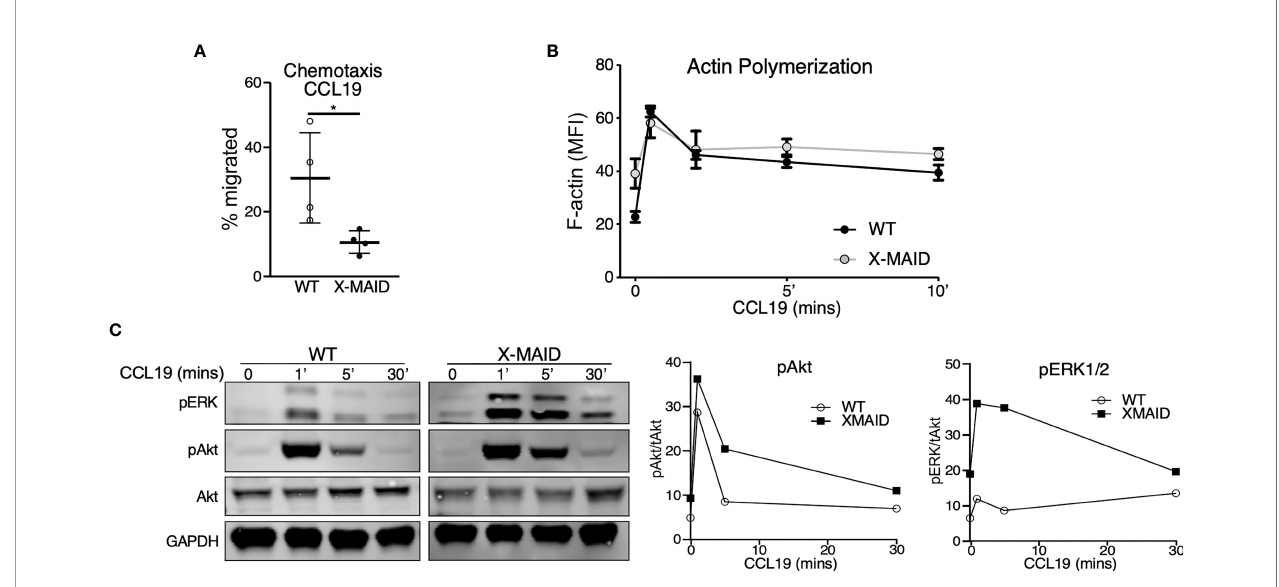
FIGURE 6 | X-MAID thymocytes are unable to properly chemotax despite intact signaling. WT or X-MAID CD4 SP thymocytes were (A) placed in the upper chamber of a 5 m m pore transwell with 100ng/ml CCL19 in the media of the bottom chamber and incubated at 37 degrees for 2 hours. Cells in the bottom chamber were counted and percent migrated calculated. Graph shows results from 4 independent experiments, with each data point representing an average of three technical replicates from one experiment. Each experiment used pooled cells from 3-5 X-MAID mice, and cells from one matched WT littermate control. Data represent means ± StDev. Statistics were calculated using a Student ’ s t test, *p < 0.05. (B) WT or X-MAID CD4 SP thymocytes were left unstimulated, or stimulated with 100ng/ml CCL19 for the indicated times, permeabilized and stained with phalloidin to assess polymerized F-actin by fl ow cytometry. (C) Thymocytes stimulated as in B were fi xed, lysed, and immunoblotted for pAkt (Ser473), pERK (Thr202/204), and total Akt and GAPDH as loading controls (left). WT and X-MAID samples were handled and analyzed in parallel. Blots were quanti fi ed by densitometry, and relative values were calculated after normalization to total Akt (right). For (B, C) , each experiment used pooled cells from 3-5 X-MAID mice, and cells from one matched littermate control. Results are representative of 3 independent